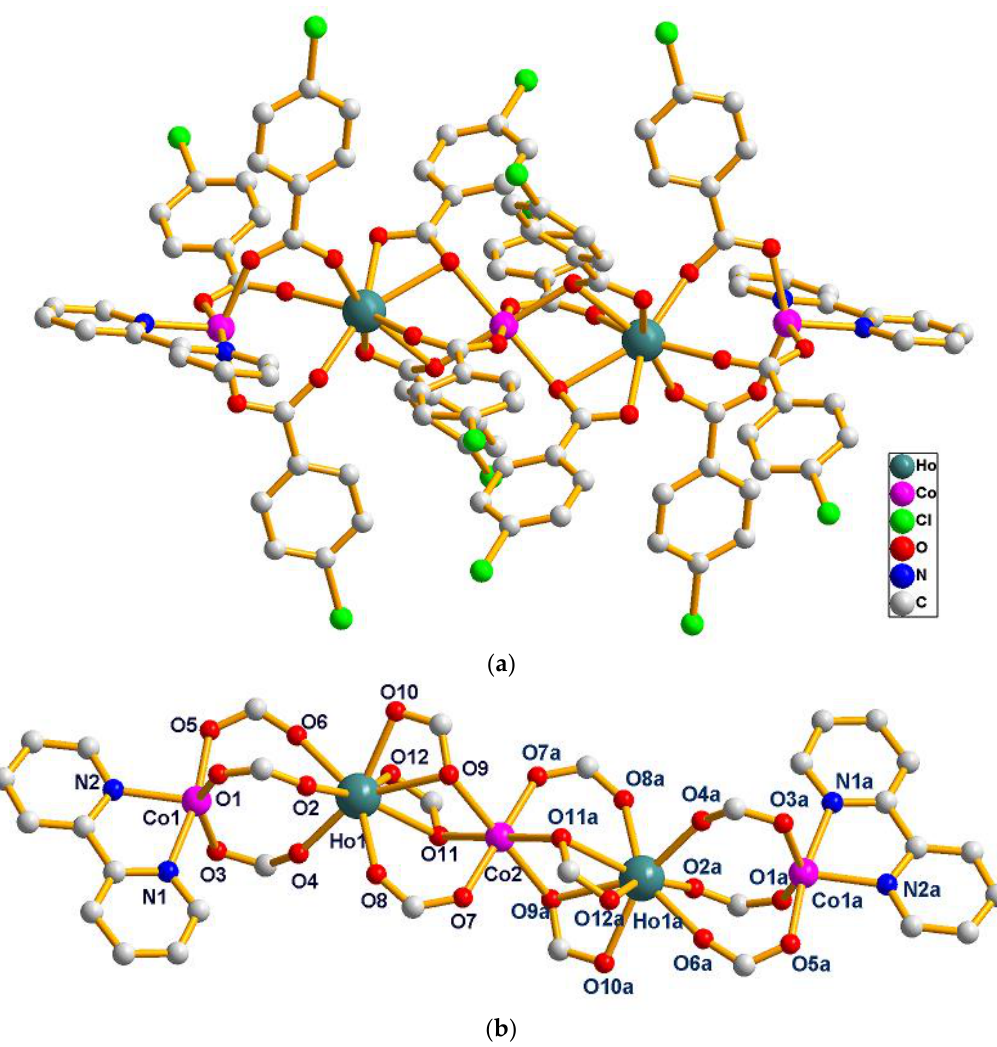
Figure 6. ( a ) The molecule structure of the pentanuclear [Ho 2 Co 3 (L1) 12 (bipy) 2 ] of 14. Hydrogen atoms are omitted for clarity. ( b ) The coordination environments of the metal centers in 14 . Polymers 2019 , 11 , x FOR PEER REVIEW